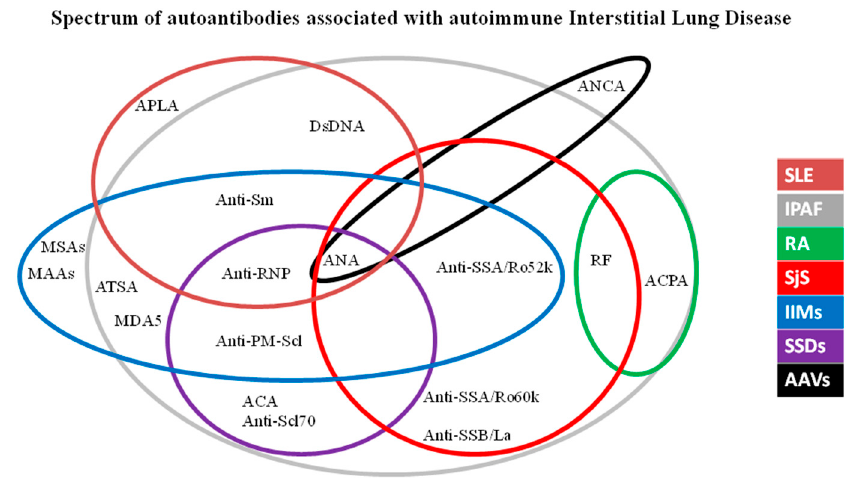
Figure 2. Spectrum of autoantibodies associated with autoimmune interstitial lung disease. Legend: AAVs: ANCA (Anti-Neutrophil Cytoplasm Antibody)-Associated Vasculitis; ACPA: Anti-Citrullinated Protein Antibody; ANA: Antinuclear Antibodies; APLA: Anti-phospholipid antibodies; ATSA: Anti-T-RNA-synthetase antibodies; IIMs: Idiopathic Inflammatory Myopathies; IPAF: Interstitial Pneumonia with Autoimmune Features; MAAs: Myositis-associated antibodies; MSAs: Myositis-specific antibodies; RA: Rheumatoid Arthritis; RF: Rheumatoid Factor SjS: Sjögren’s Syndrome; SSDs: Scleroderma Spectrum